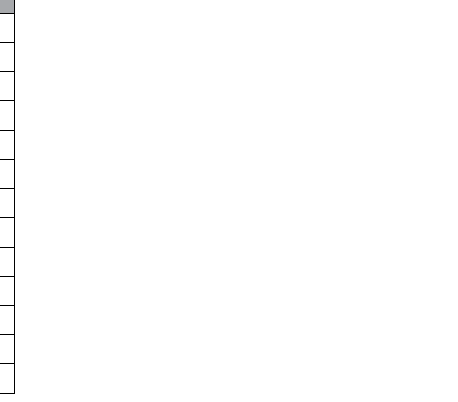
Table 3. List of hyperparameters used in this